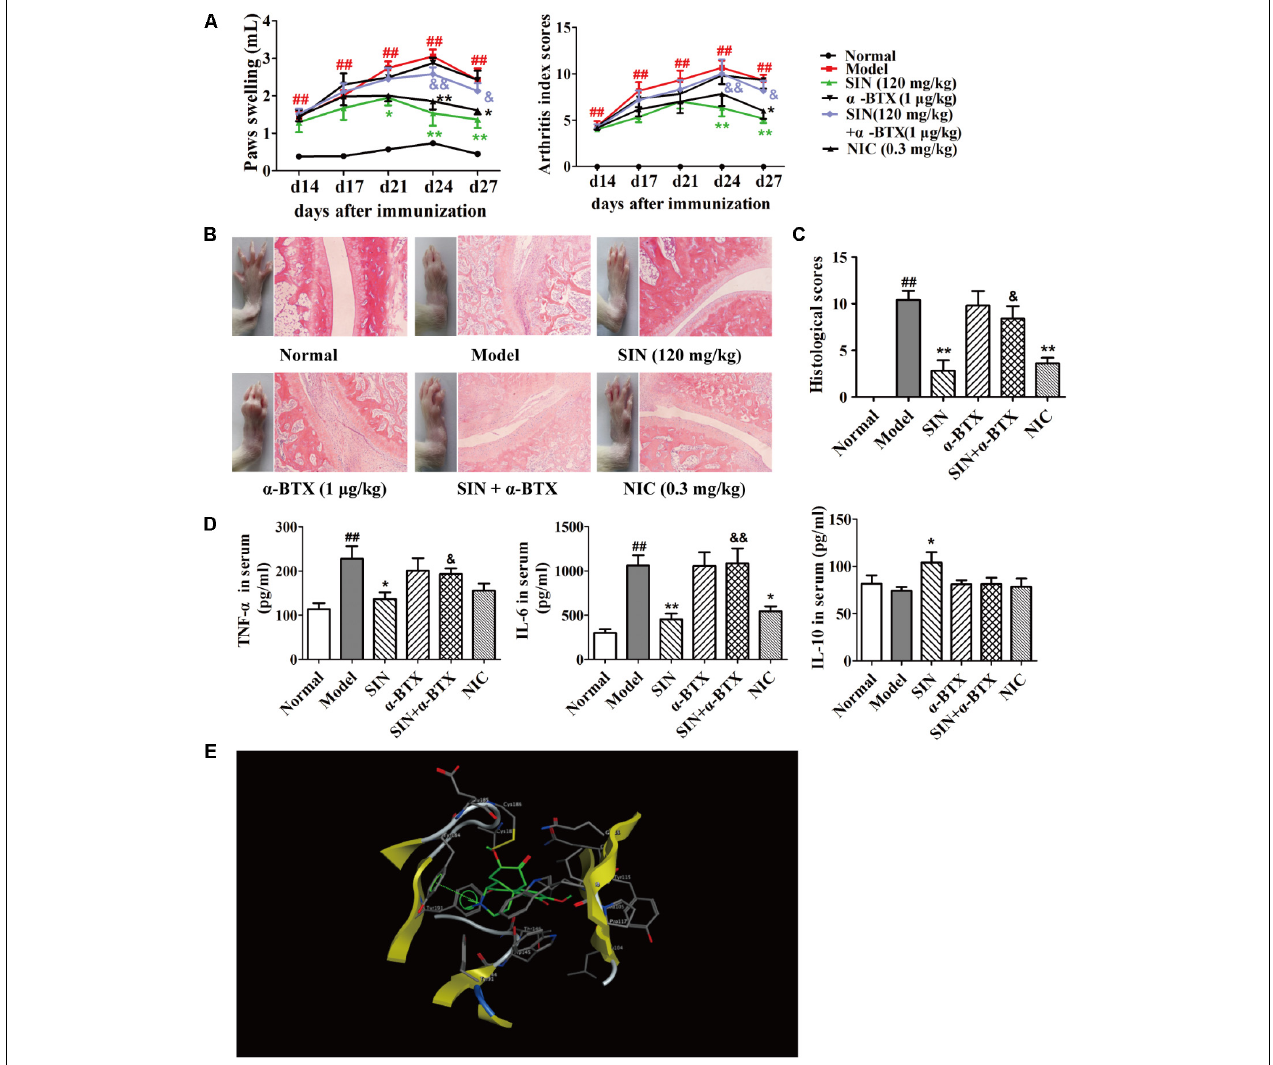
FIGURE 3 | Influence of α 7nAChR antagonist on the anti-arthritic effect of sinomenine (SIN). Rats were intragastrically administered with SIN and intraperitoneally administered with α -bungarotoxin ( α -BTX) or nicotine (NIC) from day 14 to day 28. α -BTX was given 30 min before the administration of vehicle or SIN. (A) The paw swelling and arthritis indexes were determined. (B) Photographs of representative hind paws were taken, and histopathological changes of right ankle joints in each group were determined by HE staining (original magnification 200 × ). (C) The histological scores of each group were calculated. (D) The serum levels of TNF- α , IL-6, and IL-10 were measured by ELISA. (E) The theoretical possibility of SIN binding to α 7nAChR was illustrated by molecular docking. Data were expressed as means ± SEM, n = 6–8. F -values were 13.02 for paw swelling and 8.67 for arthritis index in (A) . # P < 0.05 and ## P < 0.01 versus Normal; ∗ P < 0.05 and ∗∗ P < 0.01 versus Model; & P < 0.05 and && P < 0.01 versus